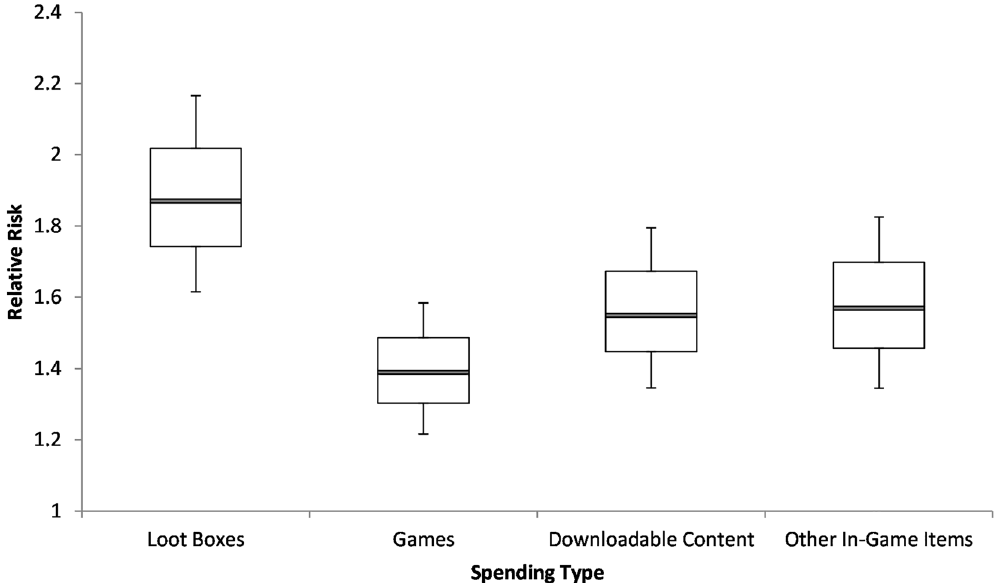
Figure 1. Relative risk of those that purchased loot boxes, video games, downloadable content, and other in-game items scoring 30 or more on the Kessler-10 psychological distress scale compared to those that did not purchase such content. White bars represent 68% confidence interval (1 SD). Error bars represent 95% confidence